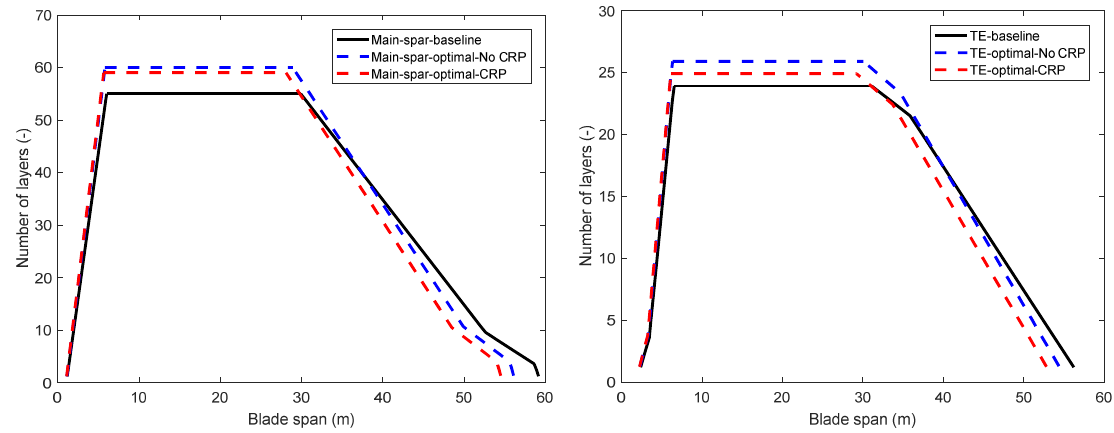
Figure 17. Structural thickness distributions of the baseline and the optimized blades. The detailed results of the design objectives of minimizing the cost of energy are shown in Table 5. The longest blade is the original one and the shortest blade is the optimization considering rated power. The optimal wind turbines have COE of 0.0478 $/kWh and 0.047 $/kWh (CRP), compared to that of 0.057 $/kWh of the initial